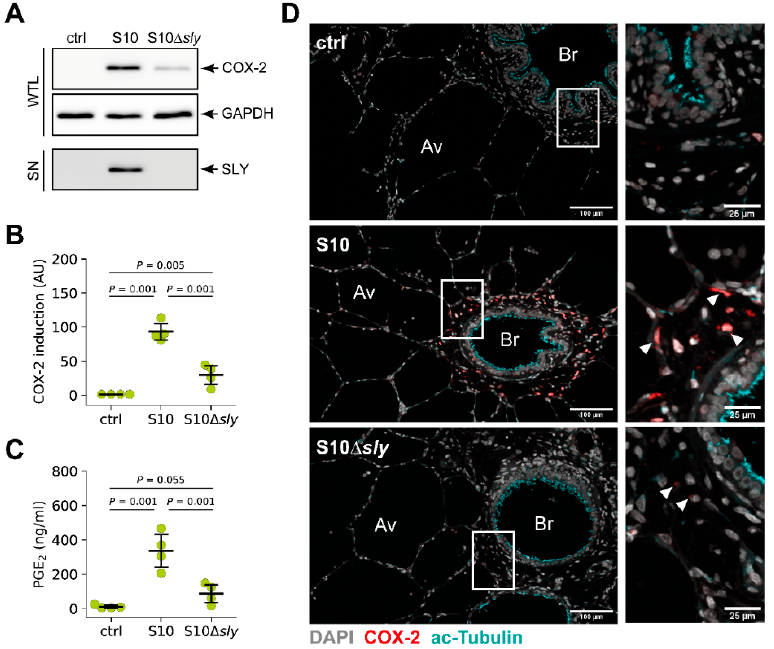
Figure 6. S. suis -induced expression of COX-2 in porcine lung tissue is suilysin (SLY)-dependent. PCLS were left uninfected (ctrl) or infected with S. suis S10 wild type and an S10 ∆ sly mutant, respectively. ( A ) COX-2 protein expression was analysed 24 h after infection by Western blotting of whole tissue lysates (WTC). GAPDH served as loading control. Expression of SLY was analysed by Western blotting of tissue culture supernatants (SN). One representative of four independent experiments is shown. ( B ) Densitometric analysis of COX-2 induction in the Western blot experiments shown in (A). Data are presented as mean ± SD of four independent experiments. Exact p values are indicated (Welch ANOVA followed by Games–Howell post hoc test). ( C ) PGE 2 production after 24 h of stimulation was determined in the supernatant by ELISA. Data are presented as mean ± SD of four independent experiments. Exact p values are indicated (Welch ANOVA followed by Games–Howell post hoc test). ( D ) Visualisation of COX-2 (red), acetylated tubulin (cyan) and nuclei (grey) in uninfected (ctrl) and infected (S10, S10 ∆ sly ) tissue by confocal microscopy. Boxed regions are shown enlarged in the right panel. Arrowheads indicate exemplary COX-2 expressing cells. One representative of three independent experiments is shown. Av, alveolar tissue; Br, bronchioles. In accordance with reduced COX-2 protein expression, we observed a